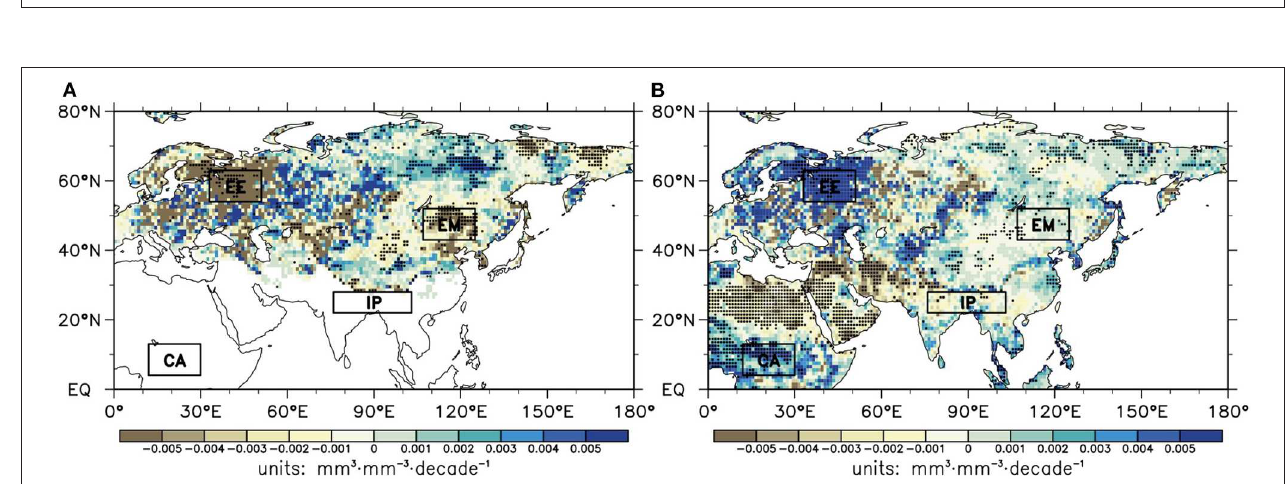
FIGURE 3 | Same as Figure 1 , but for (A) soil moisture and (B) soil temperature.